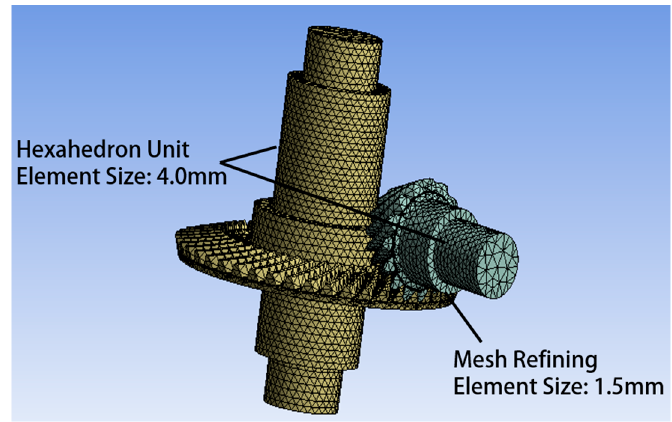
Figure 9. Mesh generation of spiral bevel gear.